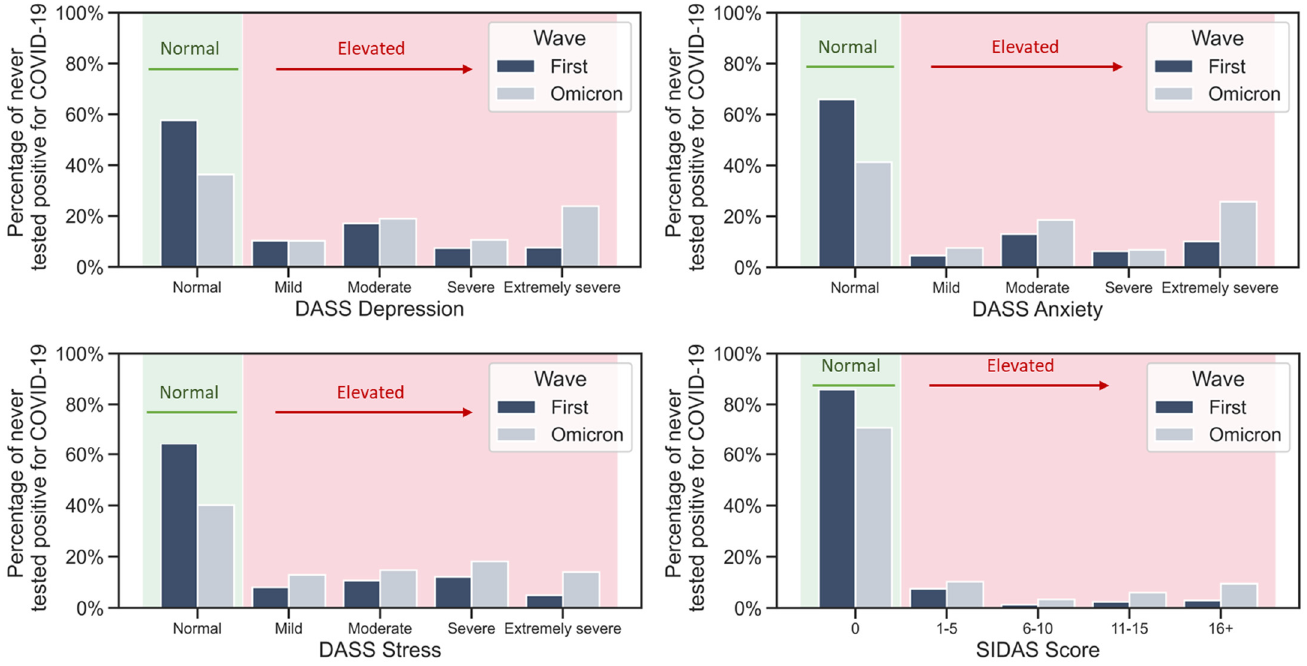
Figure 4. Distribution of DASS Depression, DASS Anxiety, DASS Stress, and SIDAS scores by category in the first and the Omicron wave, among the respondents who had never tested positive for COVID-19. The same increase can be observed in the total sample of respondents.